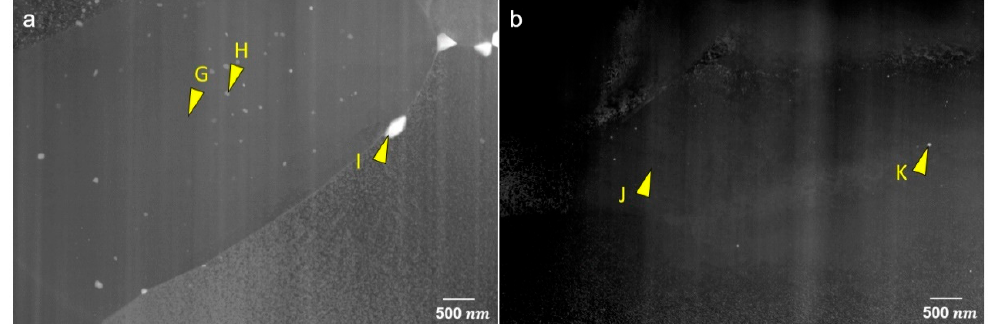
Table 2. Chemical composition (in at.%) of the matrix and particles in homogenized ZAXM2100 and 4100 alloys indicated by yellow arrows inserted in Figure 8.